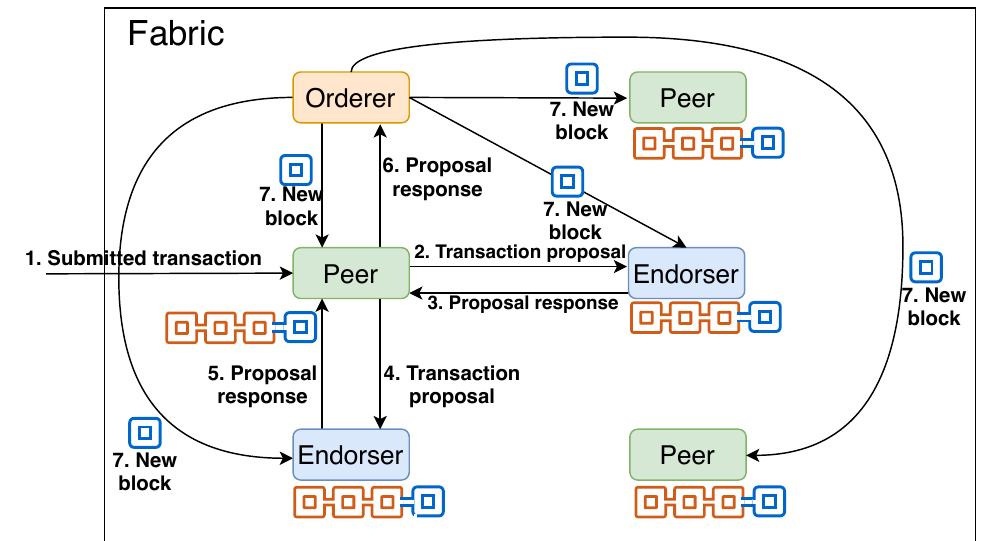
Figure 1. Flow of activities in